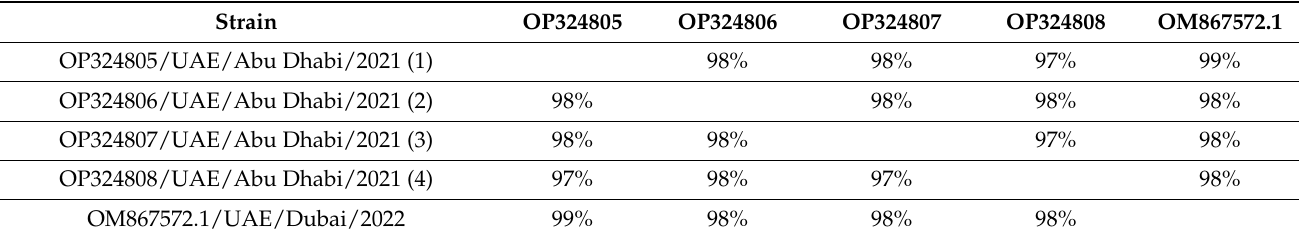
Table 3. Estimation of pairwise identity between PPRV N gene of this study strains and the newly published sequence from Barberry sheep ( OM867572.1/UAE/Dubai/2022). Numbers in brack- ets are PPRV UAE 2021 strains.